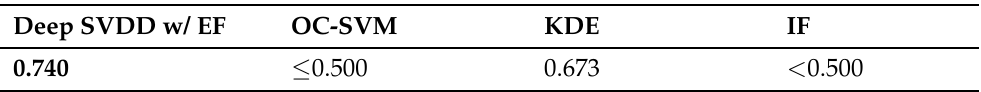
Table 4. ROC AUC results for anomaly detection on multi-perspective dices dataset using the denoising early fusion technique (Deep SVDD w/ EF). In addition, the results of the shallow anomaly detection methods OC-SVM, KDE and IF (see Section 3.1). The performance of Deep SVDD and IF are average values for 3 and 60 experiments,